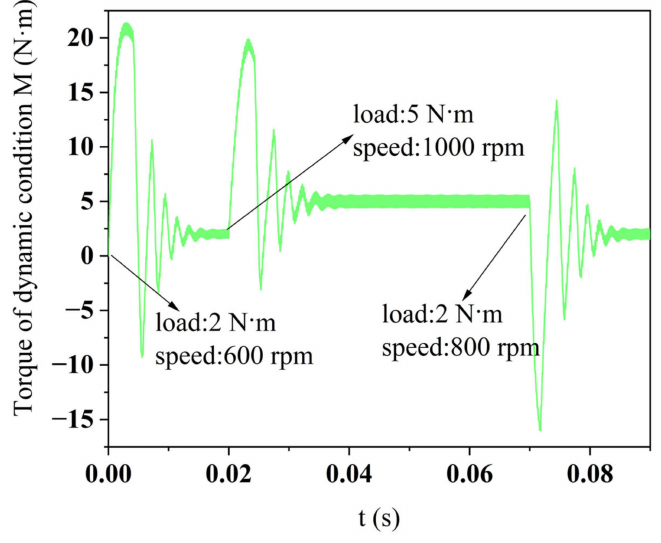
Figure 8. Torque of dynamic condition M.